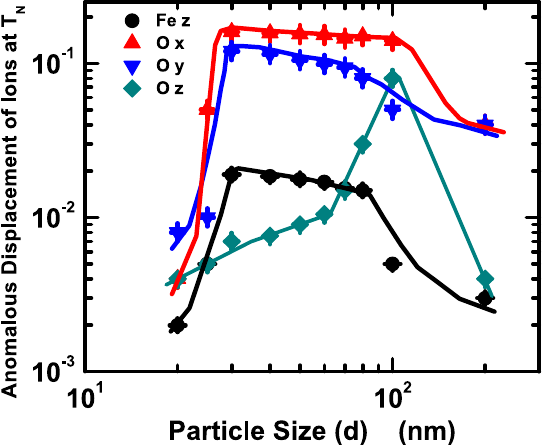
Figure 3. Particle size dependence of anomalous displacement of Fe and O ions at T N .